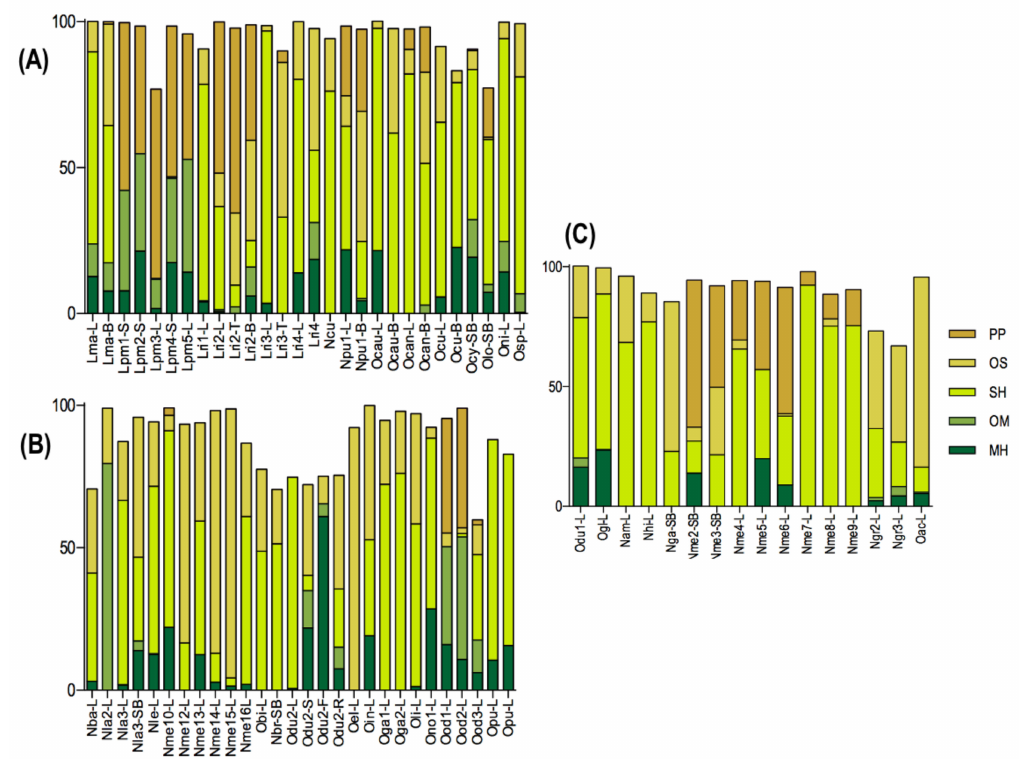
Figure 2. Distribution of compound class identified in essential oils from Nectrandra , Licaria and Ocotea species collected in Brazilian biomes. ( A ) EOs from Amazon: Licaria martiniana (Lma-L, Lma-S), L. puchury-major (Lpm1-S, Lpm2-S, Lpm3-L, Lpm4-S, Lpm5-L); L. rigida : (Lri1-L, Lr2-L, Lr3-L, Lri4-B), Nectandra cuspidata (Ncu-L), N. puberula (Npu-L, Npu-B), Ocotea caudata (Ocau-L, Ocau-B), O. caniculata (Ocan-L, Ocan-B), O. cujumary (Ocu-L, Ocu-B), O. cymbarum (Ocy-SB), O. longif ó lia (Olo-SB), O. nigrescen (Oni-L),), O. splendens (Osp-L); ( B ) EOs from biomes Caatinga, Cerrado and Pampa: Ocotea duckei (Odu1-L), O. glomerata (Ogl-L), Nectandra amazonum (Nam-L), N. hihua (Nhi-L), N. gardneri